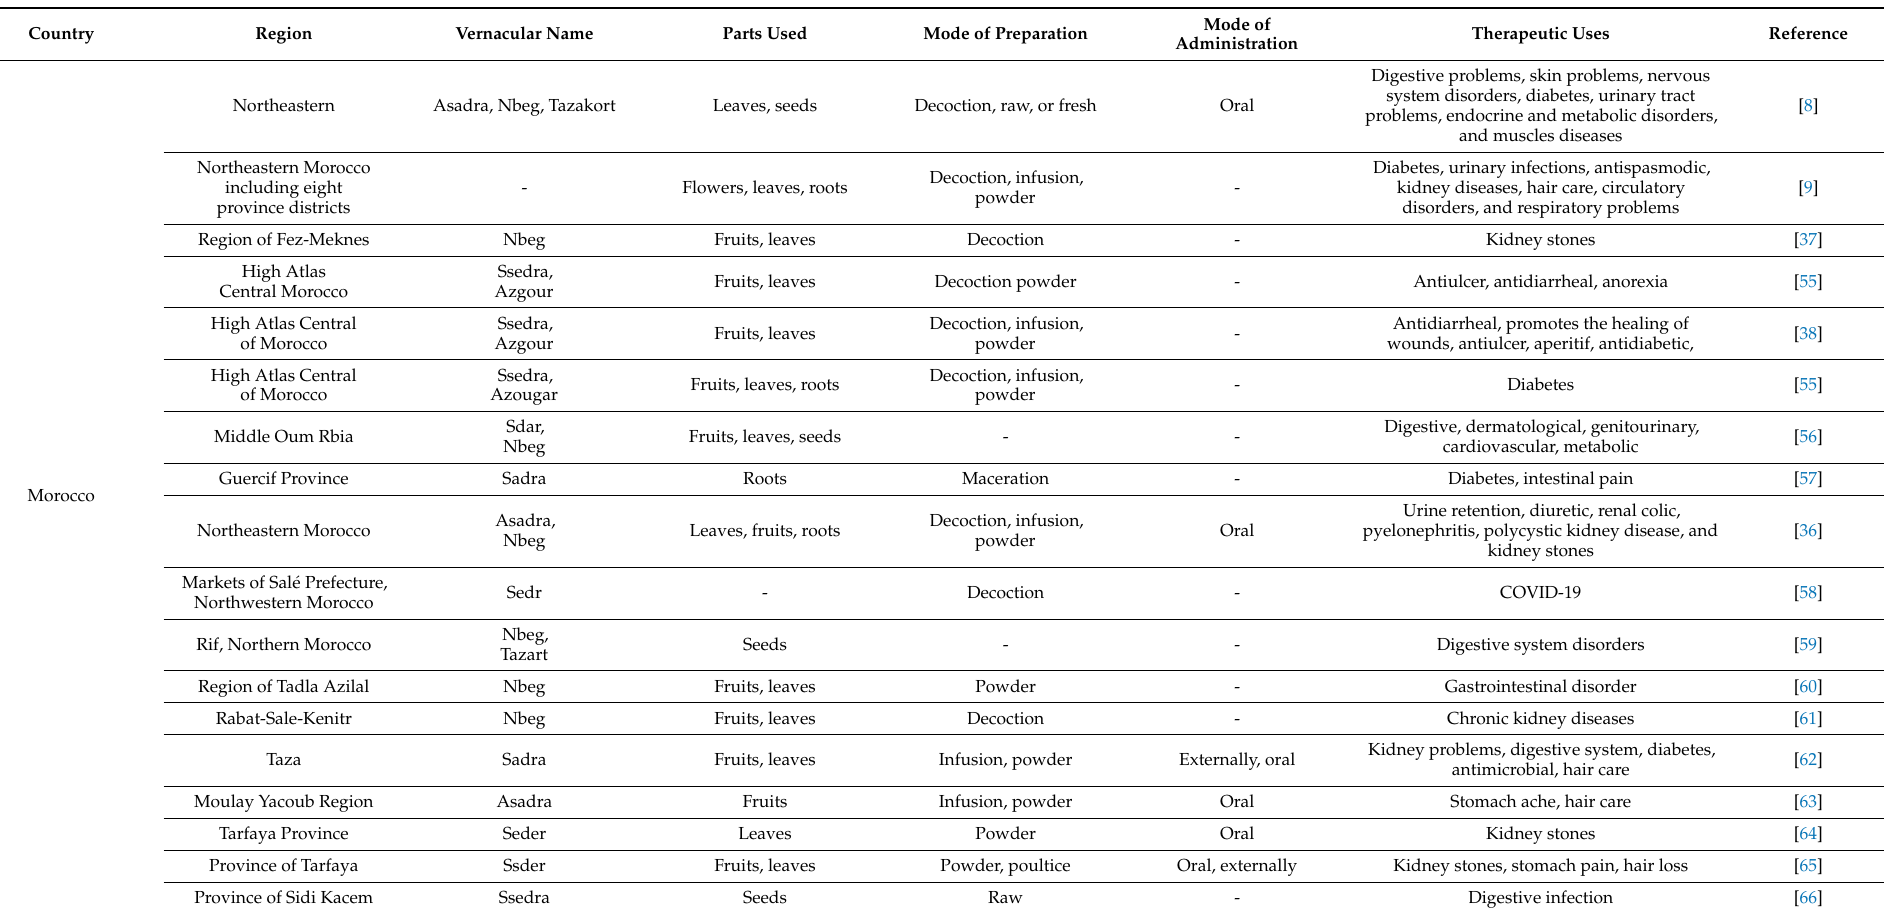
Table 1. Ethnobotanical uses of Z. lotus